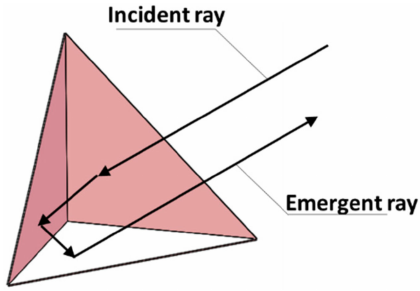
Figure 4. Optical path diagram of